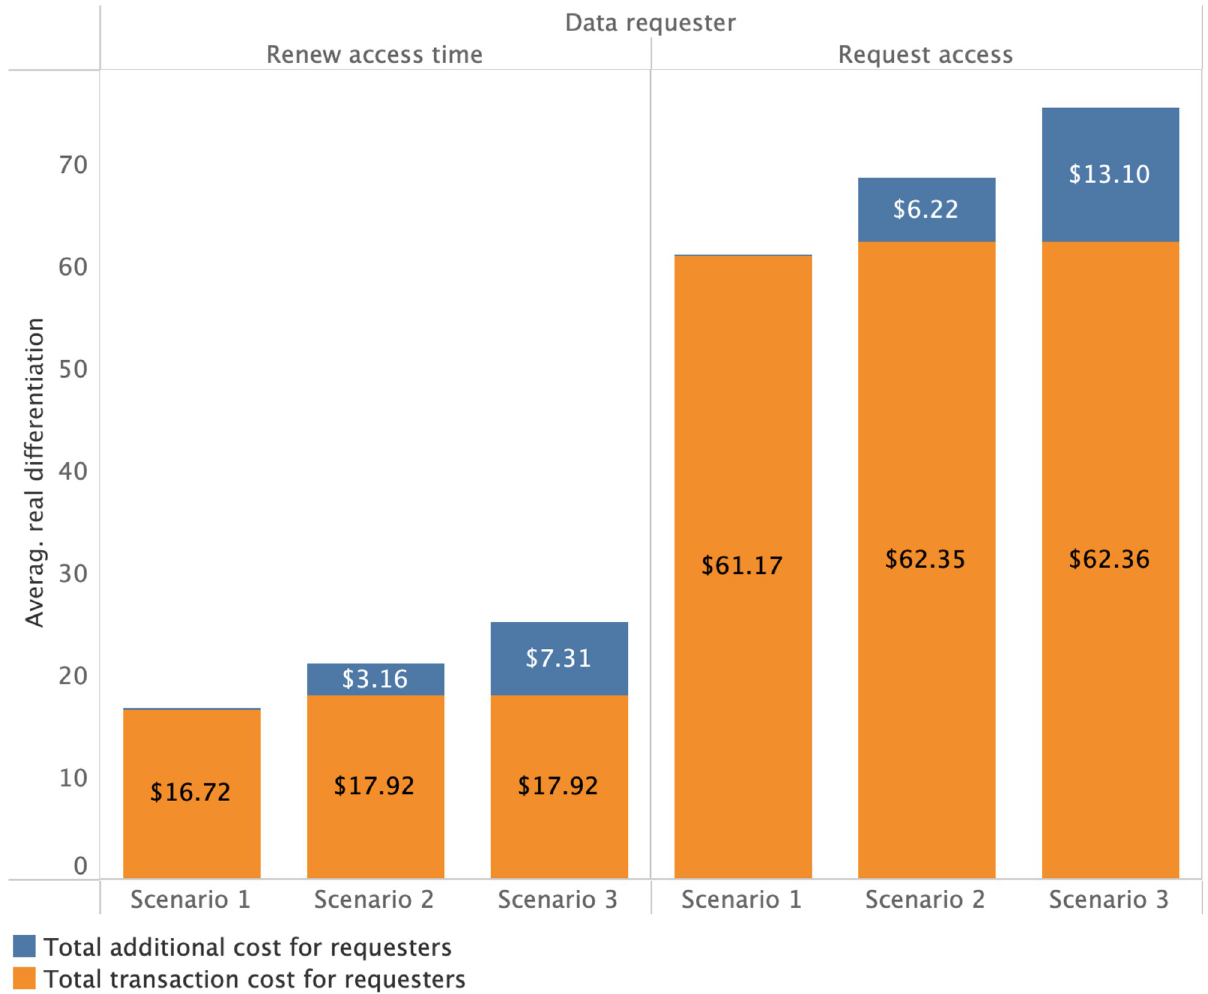
Fig 5. Additional transaction costs for data requesters to access a